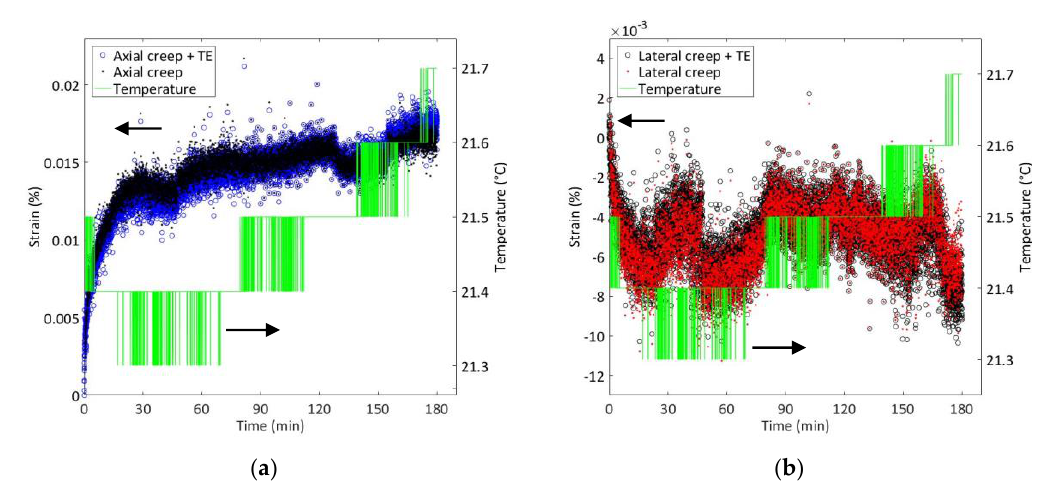
Figure 5. ( a ) Axial and ( b ) lateral creep deformations of LSCF-P5 sample for 3 h under 50-MPa maximum stress superimposed with a temperature measurement during the experiment.